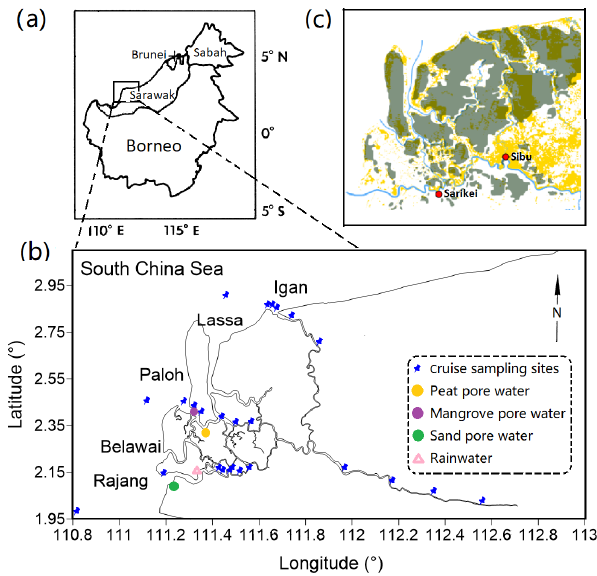
Figure 1. Maps of the sampling area: (a) shows the location of the Rajang lower stream in Borneo, which is invoked from Staub et al. (2000); (b) highlights the sampling sites in the September 2017 cruise; (c) outlines the distribution of peatland in the Rajang lower steam and coastal region (dark green) and deforestation (yellow) in 2010 (Sarawak Geoportal: http://www.bmfmaps.ch, last access: Oc- tober 2018). The cyan line indicates the Rajang River. The red dots represent Sarikei and Sibu. Both are important cities in the Rajang